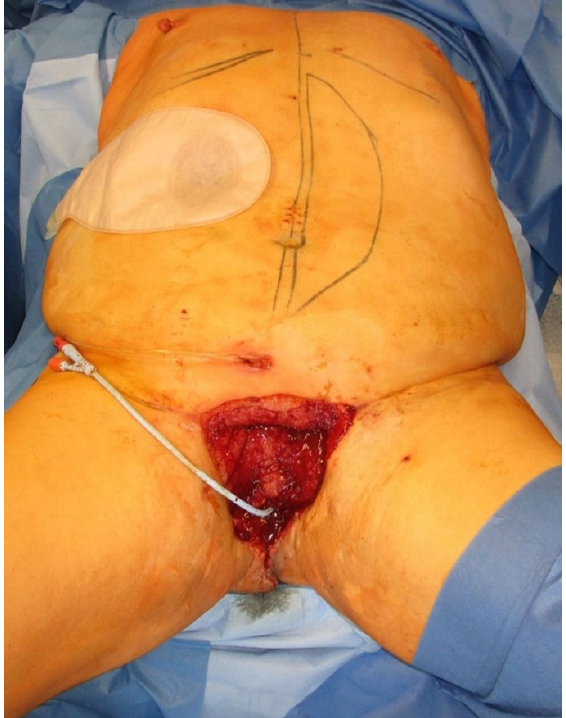
Figure 3. After adequate debridement, defect reconstruction was planned with an extrapelvic VRAM flap from the left abdomen. Skin paddle is marked.